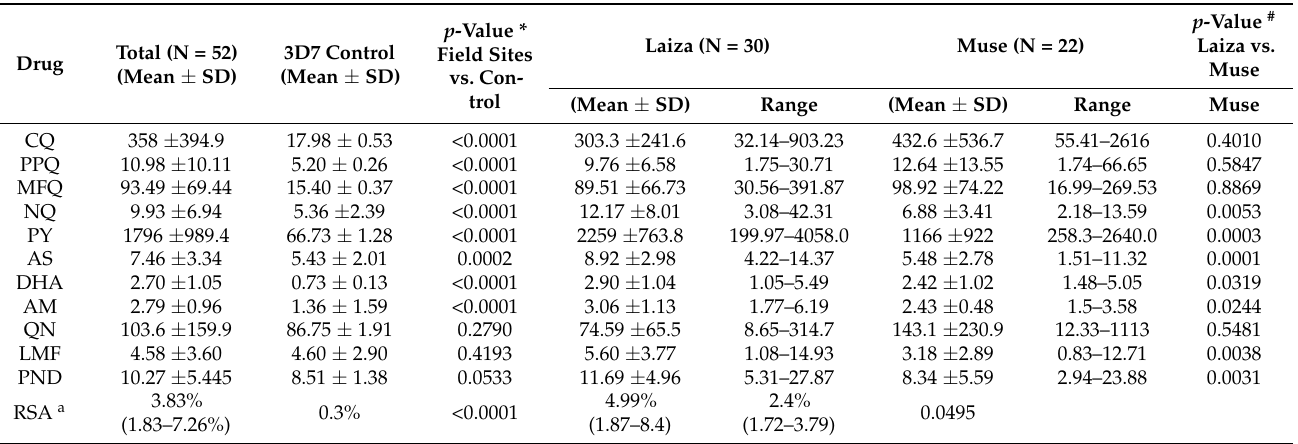
* Comparison between total field isolates and 3D7 by the Wilcoxon matched-pairs signed-rank test. # Comparison between the two sites by the Mann–Whitney U test. a The ring survival assay (RSA) values are shown